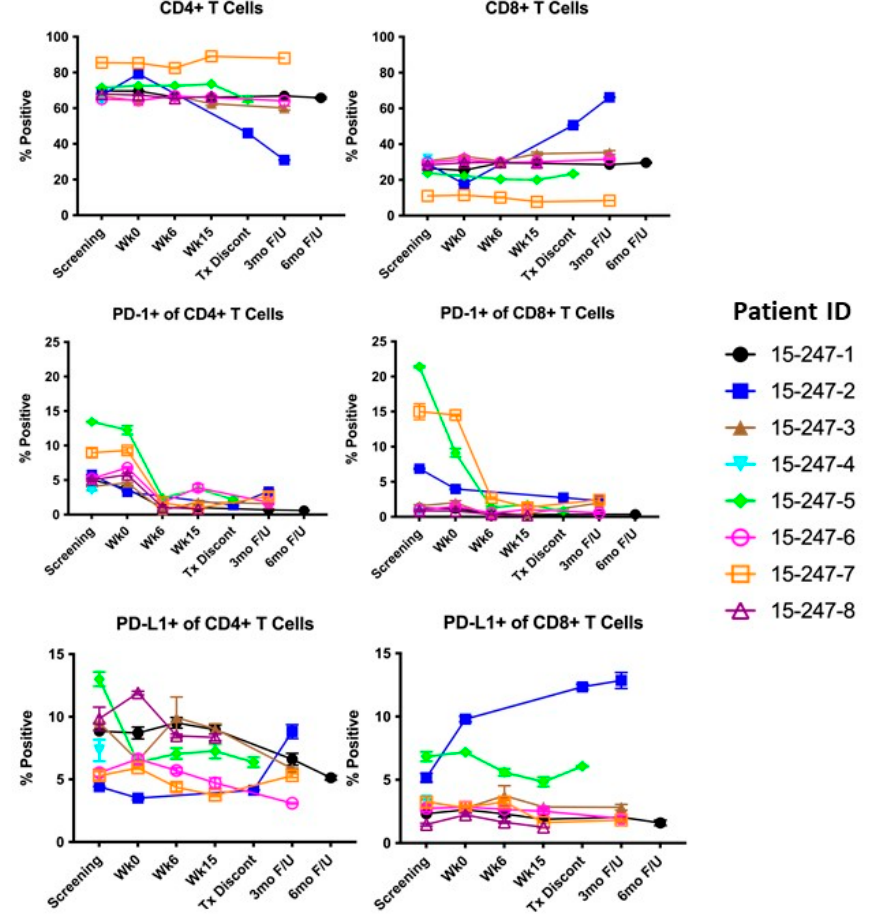
Figure 1. Summary of cell subpopulation frequencies over time. Tx Dicont, Treatment Discontinua- tion; 3 mo F/U, 3-month follow-up; 6 mo F/U, 6-month follow-up; PD-1, programmed cell death protein 1; PD-L1, programmed death-ligand 1.